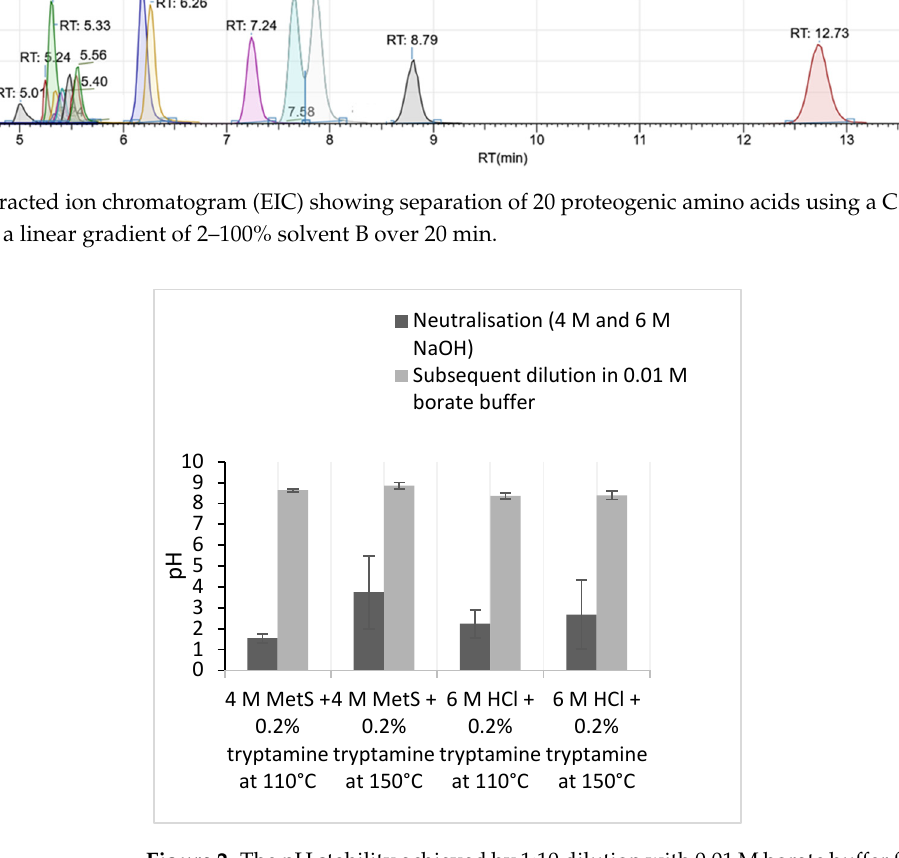
Figure 1. Extracted ion chromatogram (EIC) showing separation of 20 proteogenic amino acids using a C18 reversed phase column with a linear gradient of 2–100% solvent B over 20 min.